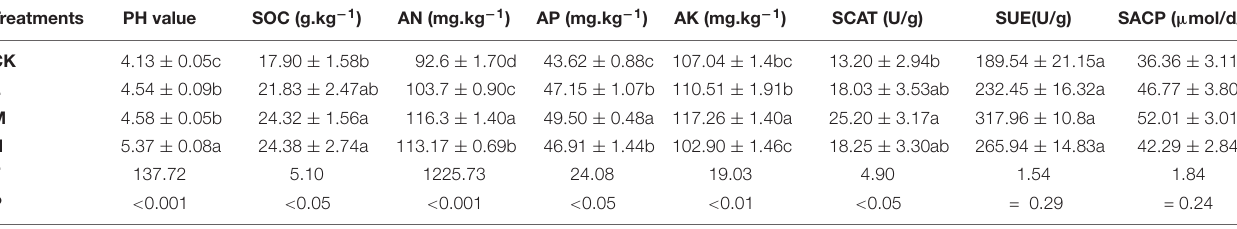
TABLE 1 | Effect of different treatments on soil nutrients and enzymatic activity. Treatments